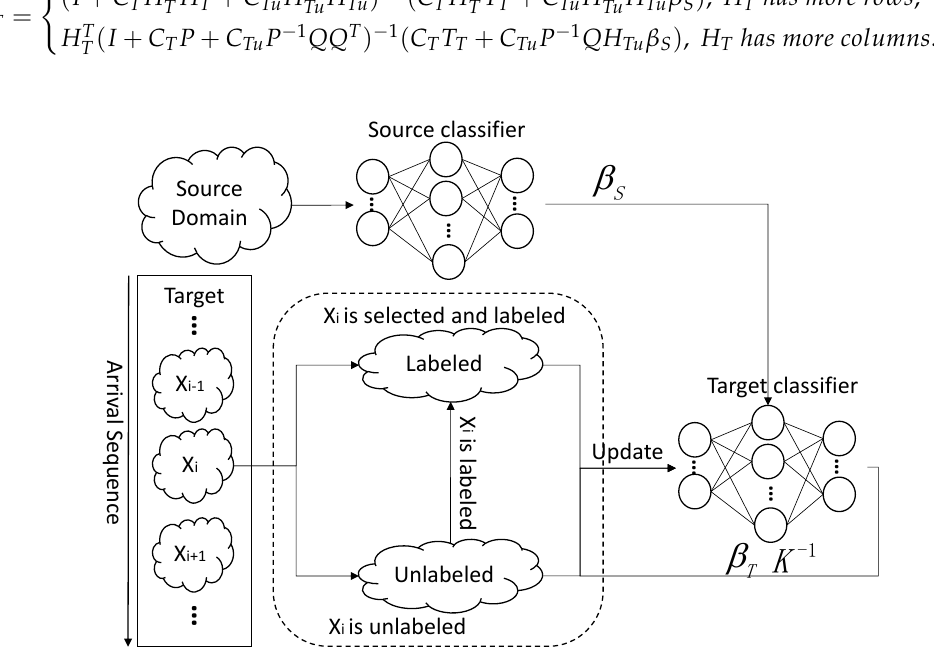
Figure 3. Online updating of ODAELM-T regarding different